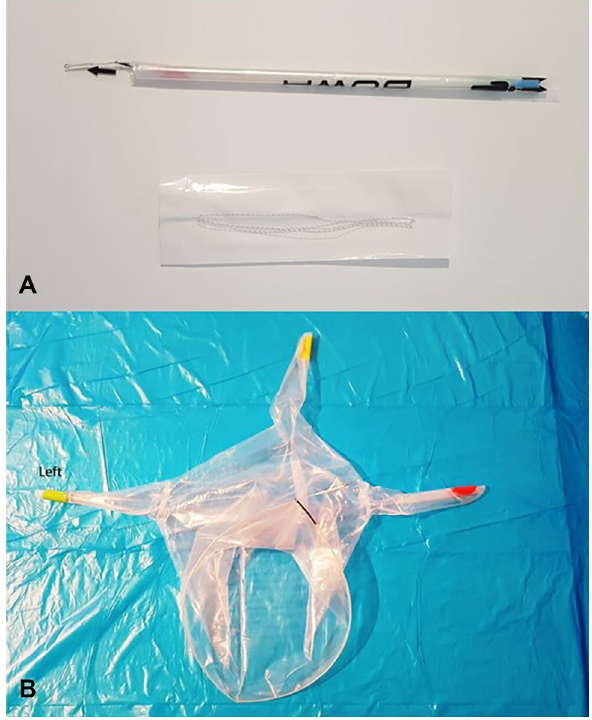
Figure 1. ( A ) Endobag with introducer and closure strings; ( B ) Unfolded